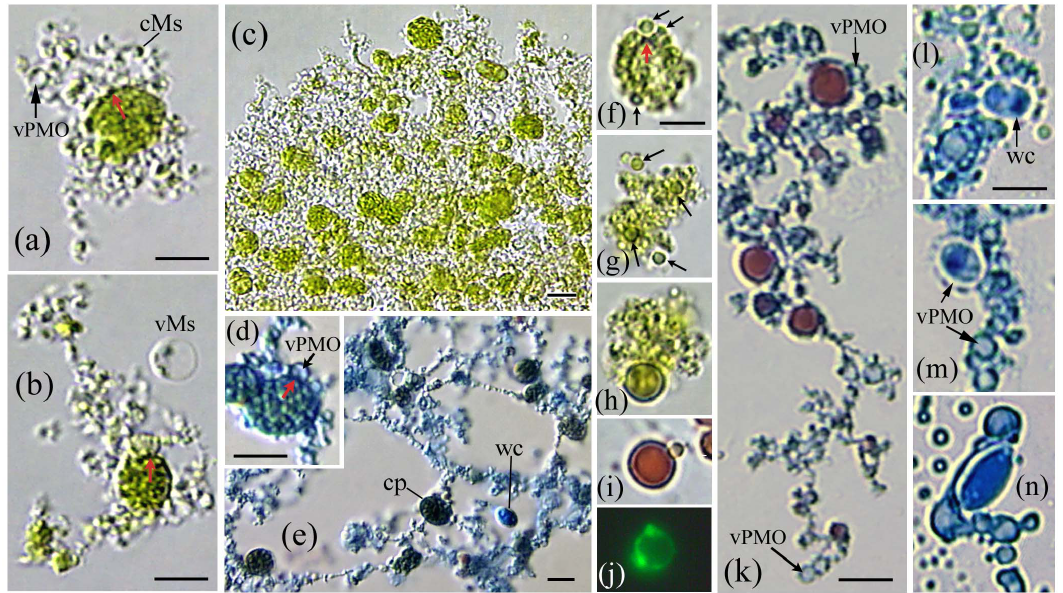
Figure 8. Protoplast filaments from Psilotum contain chloroplasts and form A.pullulans cells within PMOs. (a–b) Protoplast filaments develop from the margin of Psilotum chloroplasts; note that portions of the plastid envelope contain dark punctate bodies (also f, red arrows). (a) Vacuolate-PMOs (vPMO) enlarge within the filaments, and (b) pinch-off as spheroid vacuolate-Ms (vMs). (b) Filaments radiating from chloroplasts also contain small chloroplasts. (c) The filaments mature as a dense chloroplast-containing matrix; or (e), expand as fenestrated, chloroplast (cp)- containing filaments (AB stain). Walled cells (wc) occasionally develop within the ‘open’ areas. (d) vPMOs apparently develop from the AB-staining chloroplast margin (red arrow). (f–h) Psilotum chloroplasts release green Ms (black arrows) from outside a dark chloroplast envelope (f, red arrow), and from green unbounded membranes (g–h). (h) This Type II Ms contains a greenish body, similar to Psilotum lipoid-Ms that stain red (i) with SIV. (j) SYTO-9 staining bodies are present within the Type II protoplast. (k–n) Filaments from post-reproductive stems contain numerous vPMOs (k), some expressing a lipoid body (AB/SIV stain). (l–n) Aureobasidium walled cells (wc) develop within the PMO vacuole. (n) Note presence of condensed-Ms, enlarging vacuolate-PMOs and yeast cell release from a vacuolate-PMO. Bars =5.0 m